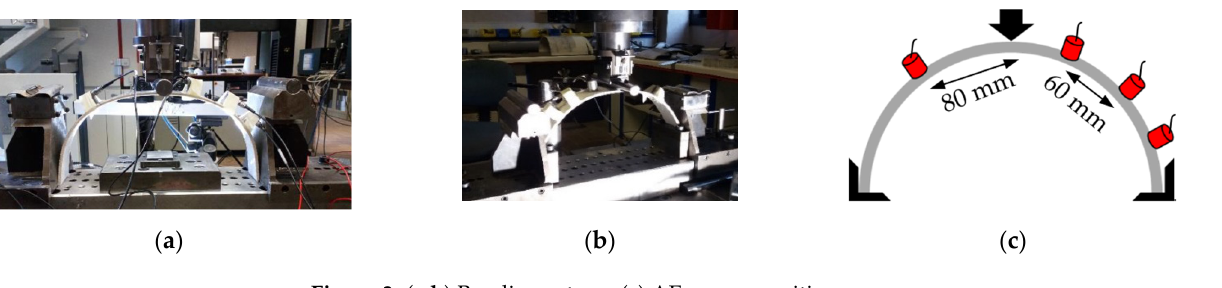
Figure 3. ( a , b ) Bending set-up. ( c ) AE sensor positions.